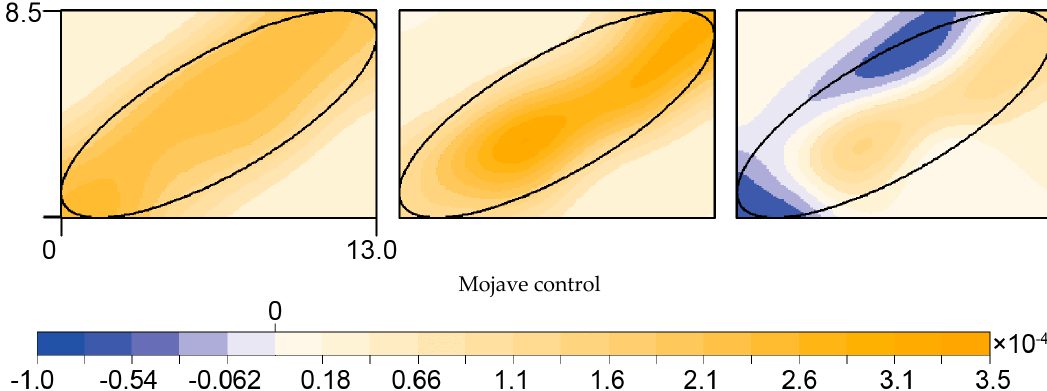
Figure 7. Kernel density estimates for solar sites. The first column is breakpoint distribution density before construction, second is density after construction, and third is the differenced density ( after - before ). The inner boundary in each panel for noncontrol sites is the outline of the solar installations; the outer boundary is a 2-km buffer from the inner boundary. Axes display distance in kilometers.